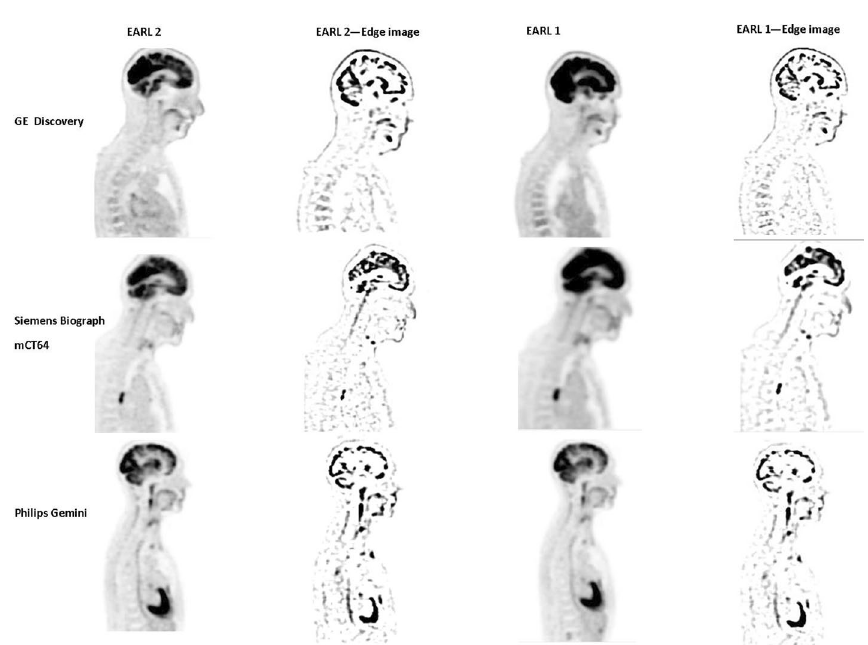
Fig. 1 Original and edge enhanced image for EARL 1 and EARL 2 compliant images and the three PET systems included in the training